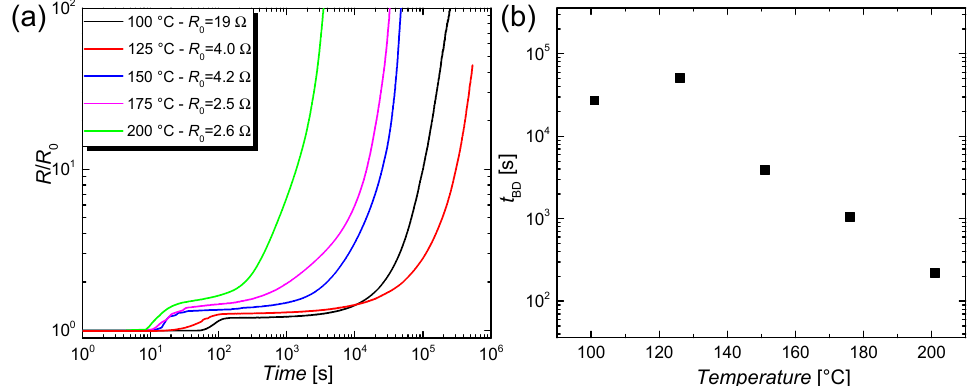
Figure 5. ( a ) Normalized increase in resistance R / R 0 over time for different temperatures. The CuNW films were placed on a hot plate in ambient air; ( b ) Breakdown time t BD as a function of the annealing temperature.